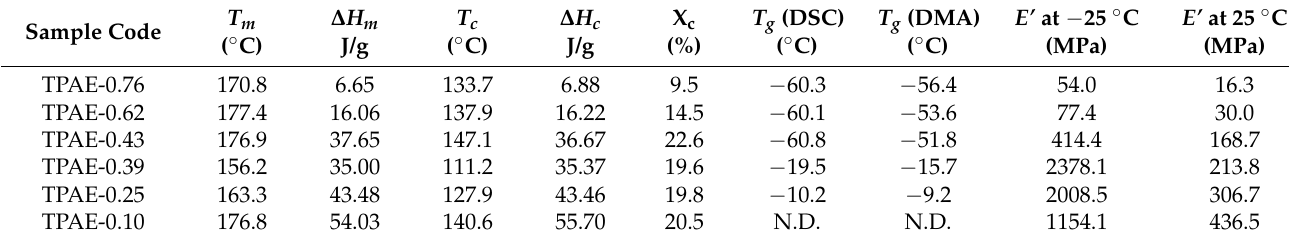
Table 2. DSC and DMA results of